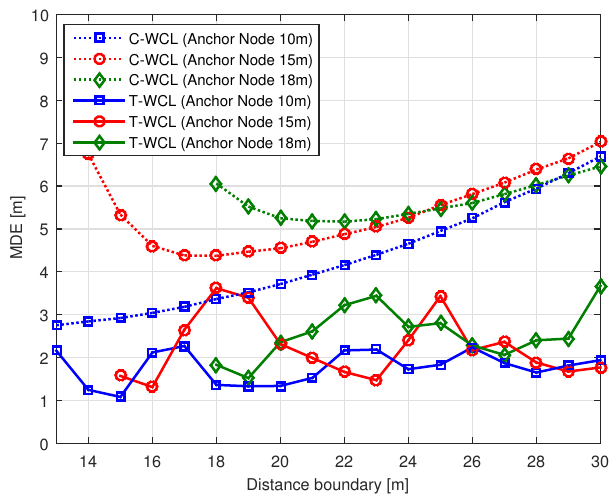
Figure 4. MDE performance according to the distance boundary with the anchor node deployment interval.